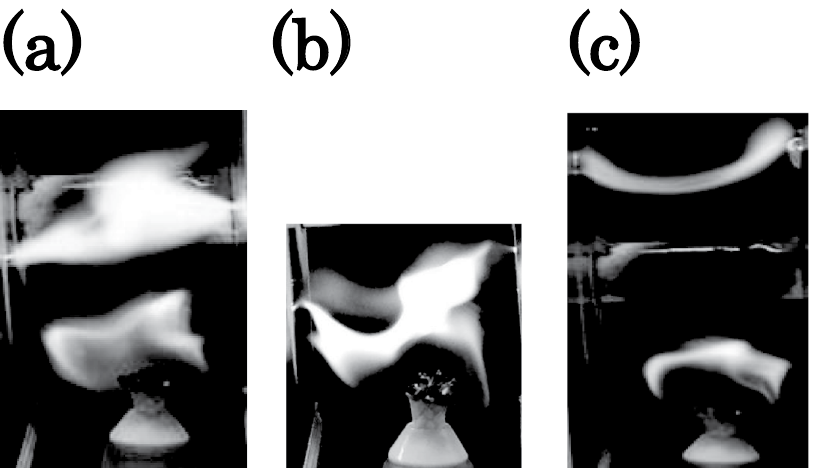
Figure 5. Change in the flame state for an extremely strong electric field is shown: ( a ) appearance of arc plasma when an ac voltage corresponding to 16,500 V is applied, ( b ) mixing state of the flame and arc plasma when an ac voltage corresponding to 16,500 V is applied, and ( c ) state when the filament of arc plasma began to run from the bottom to top between the electrodes when an ac voltage corresponding to 18,090 V is